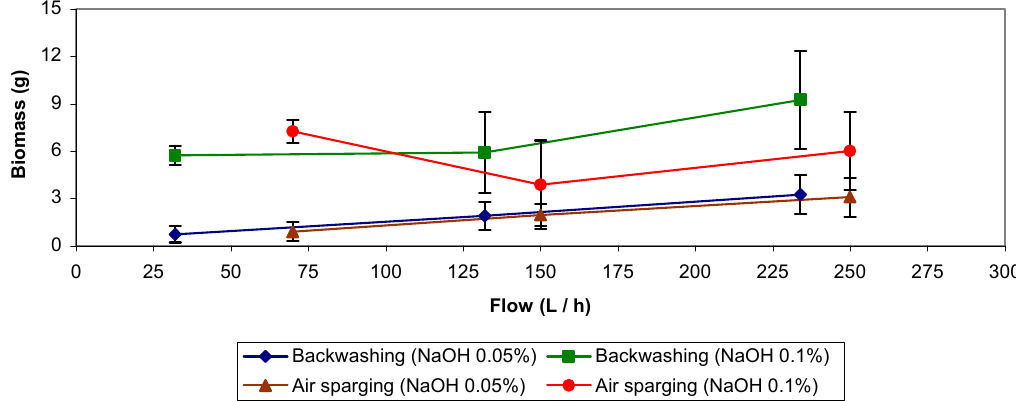
Figure 3. Backwashing and air sparging applying NaOH